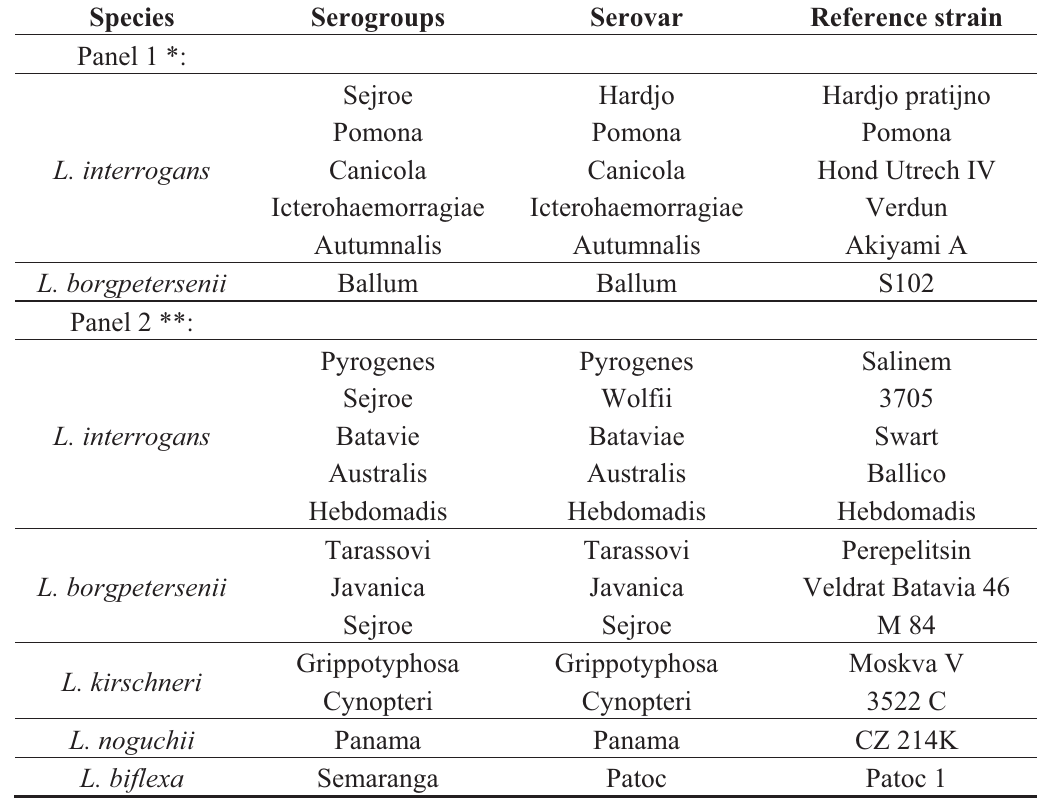
Table 1. Serogroups, serovars and reference strains of Leptospira species used for Microscopic Agglutination Test